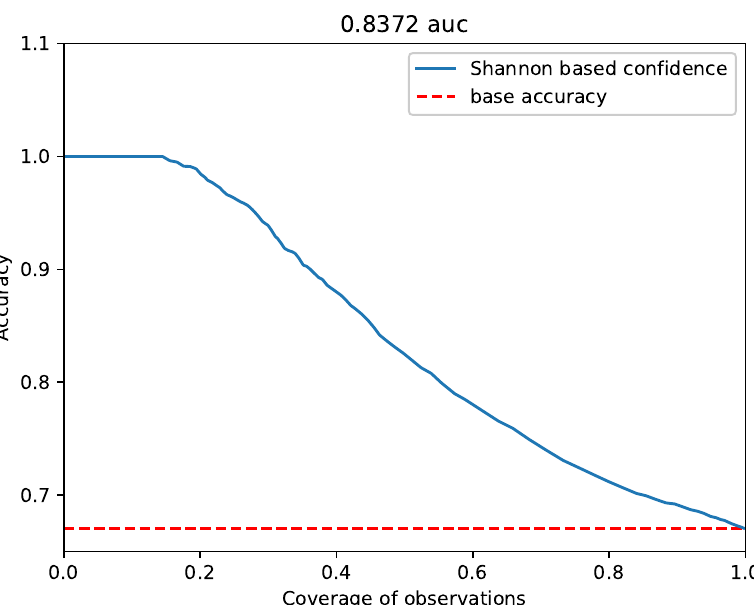
Figure 3. Plot presenting confidence curve for Shannon-based confidence, where it achieves a 0.8372 auc score.